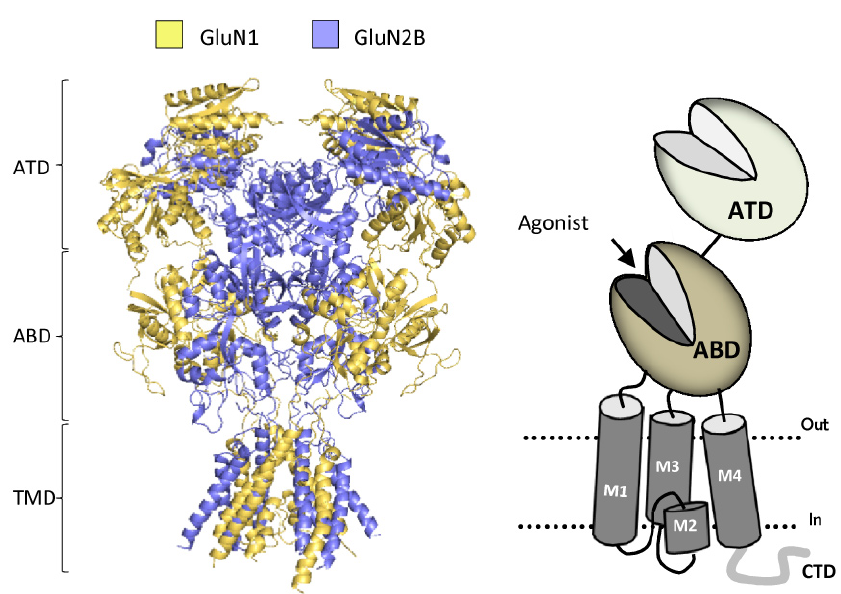
Figure 1. Domains of N -methyl- D -aspartate (NMDA) receptors. The crystal structure for GluN1/GluN2B receptors is shown in the left panel 13 depicting the amino-terminal domain (ATD), the agonist-binding domain (ABD), and the transmembrane domain (TMD). Not shown is the intracellular carboxyl-terminal domain (CTD). The right panel displays a schematic of a GRIN subunit, and the subdomains and the clamshell features of the ATD and ABD are